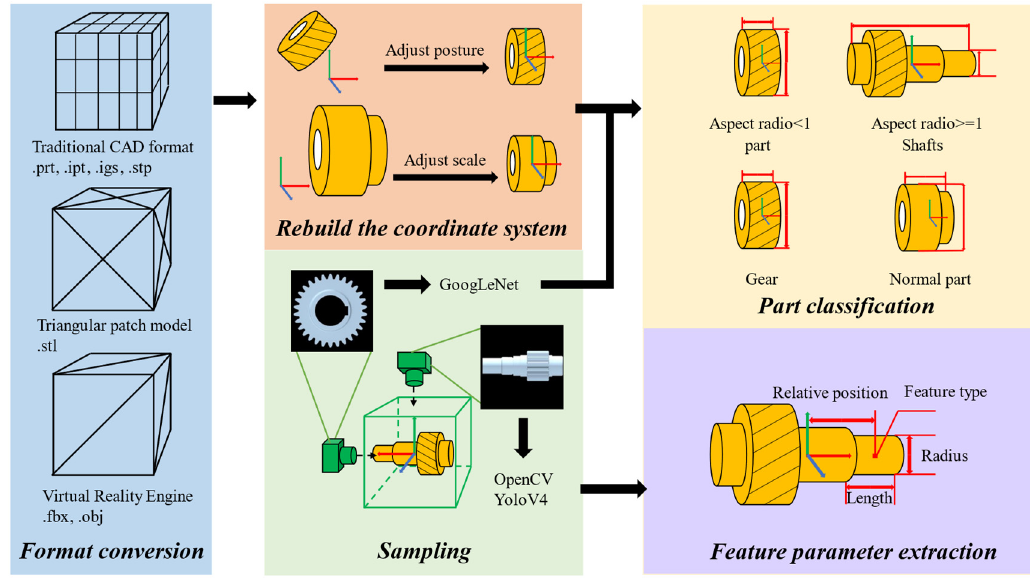
Figure 17. Technology roadmap.